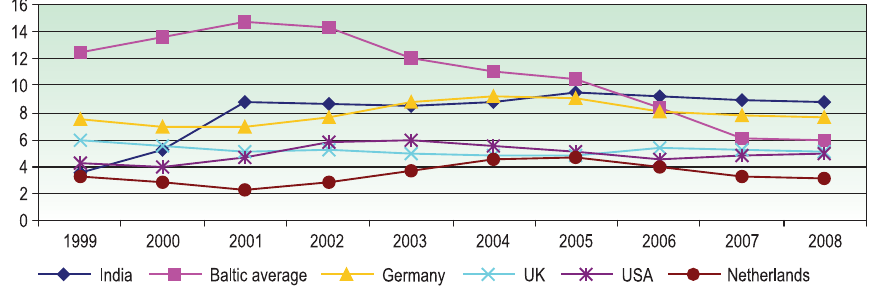
Source: IMF statistics, 2007